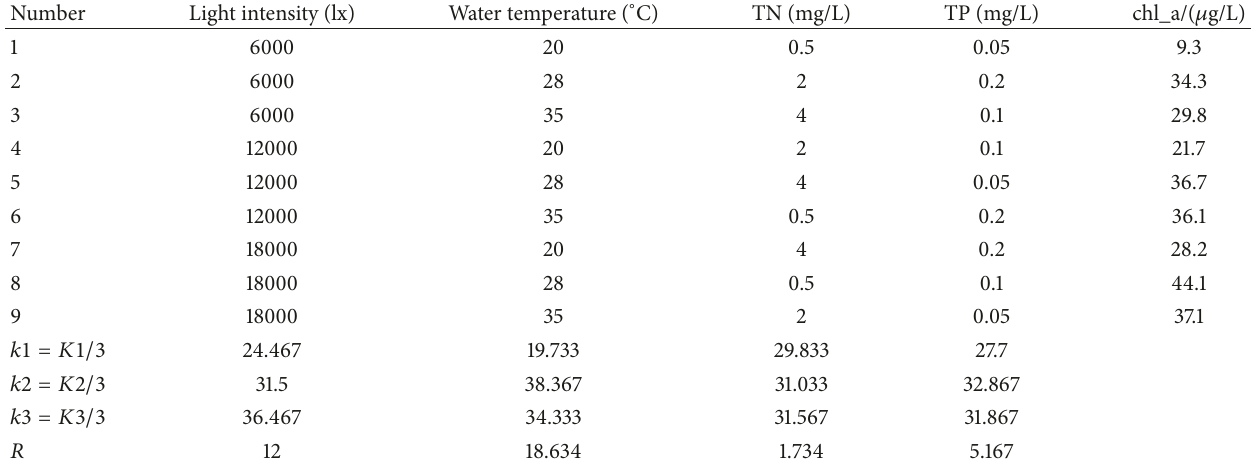
Table 4: L 9 (3 4 ) orthogonal experiment range analysis of the maximum standing crop of algae.